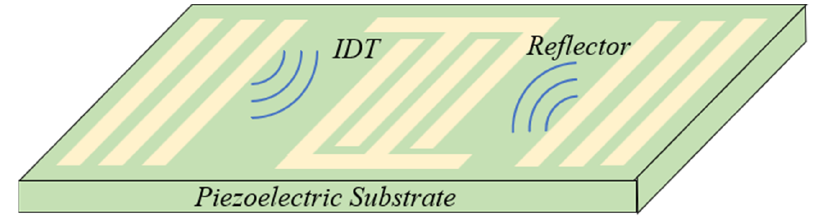
Figure 1. Schematic diagram of the SAWS.